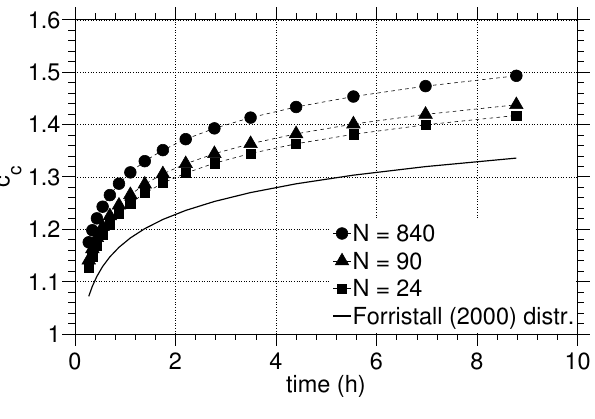
Fig. 9. Wave crest probability as a function of the sea state duration for a nominal sea state with k p H s / 2 = 0 . 13 (experiments). c c here represents the characteristic largest value for the non-dimensional wave crest c r .